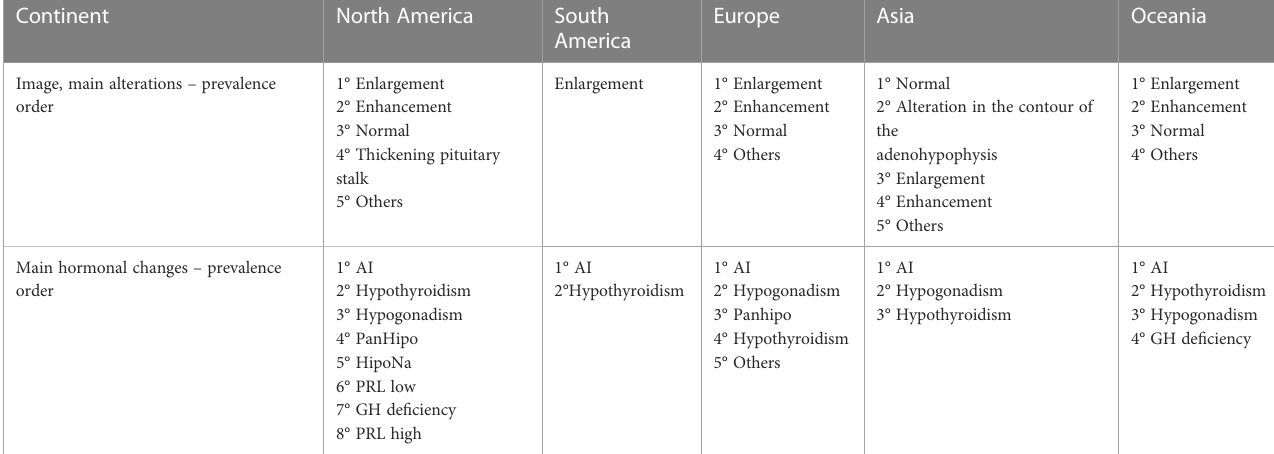
TABLE 5 Information of the case studies, case series and cohort studies describing individual cases, grouped by continent – Part 2. Continent